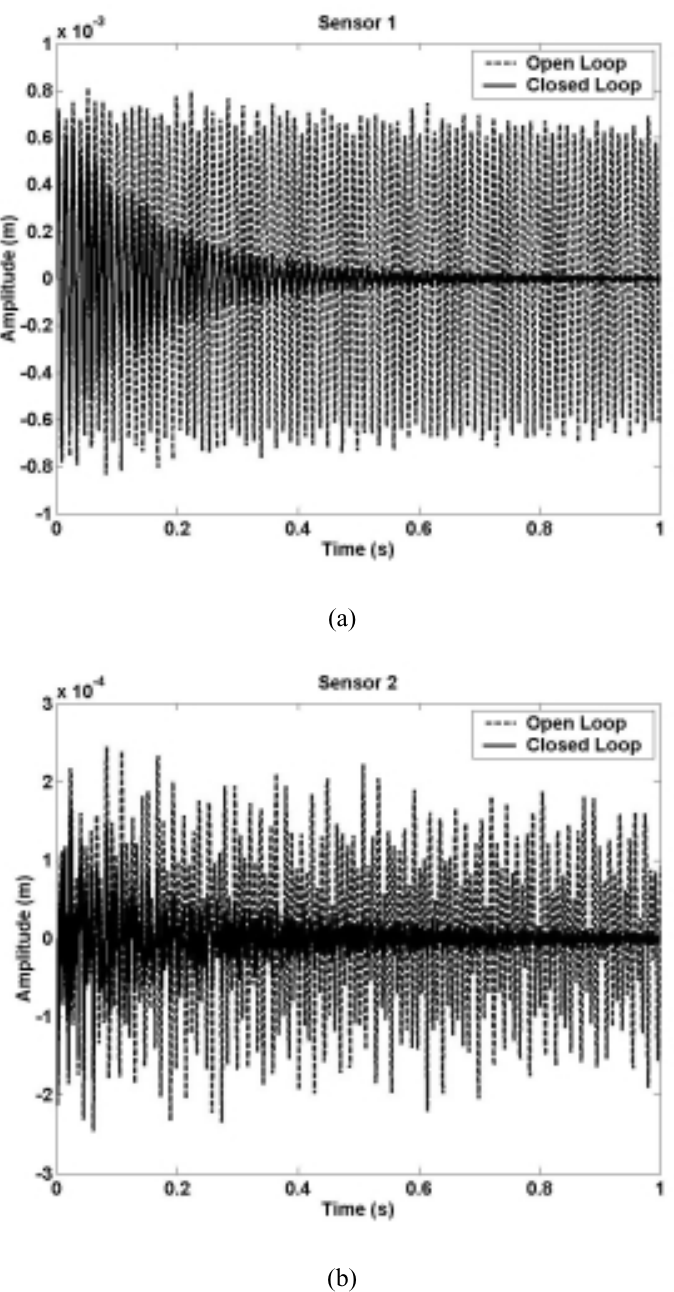
Fig. 8. Uncontrolled and controlled response for the structure at (a) sensor 1 and (b) sensor 2, when the EMC strategy is implemented. sensor/actuatorcandidate position. This methodologyis described by Carvalhal et al. [7]. These positions correspond to a situation where the actuator and sensors couple into and sense the motion to be controlled effectively. The optimal placement of the actuator and of the two sensors (to show the control performance) is shown in Fig. 1. The four sensors used for the observer design are located at nodes 5 and 9 in the x and y directions. An impulsive force is applied at node 9 in the x direction of the structure, which excites some modes of the